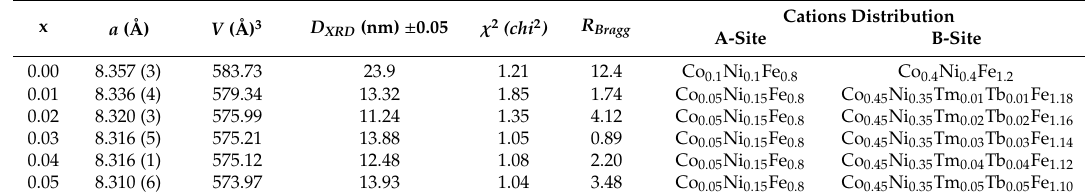
Figure1. XRDpowderpatternsof(Co 0.5 Ni 0.5 )[Tm x Tb x Fe 2 − 2x ]O 4 (x = 0.00–0.05)NSFsatroomtemperature. Figure 1. XRD powder patterns of (Co 0.5 Ni 0.5 )[Tm x Tb x Fe 2−2x ]O 4 (x = 0.00–0.05) NSFs at room temperature. Refined structural parameters and cation distribution calculations for (Co 0.5 Ni 0.5 1. Refined structural parameters and cation distribution calculations for